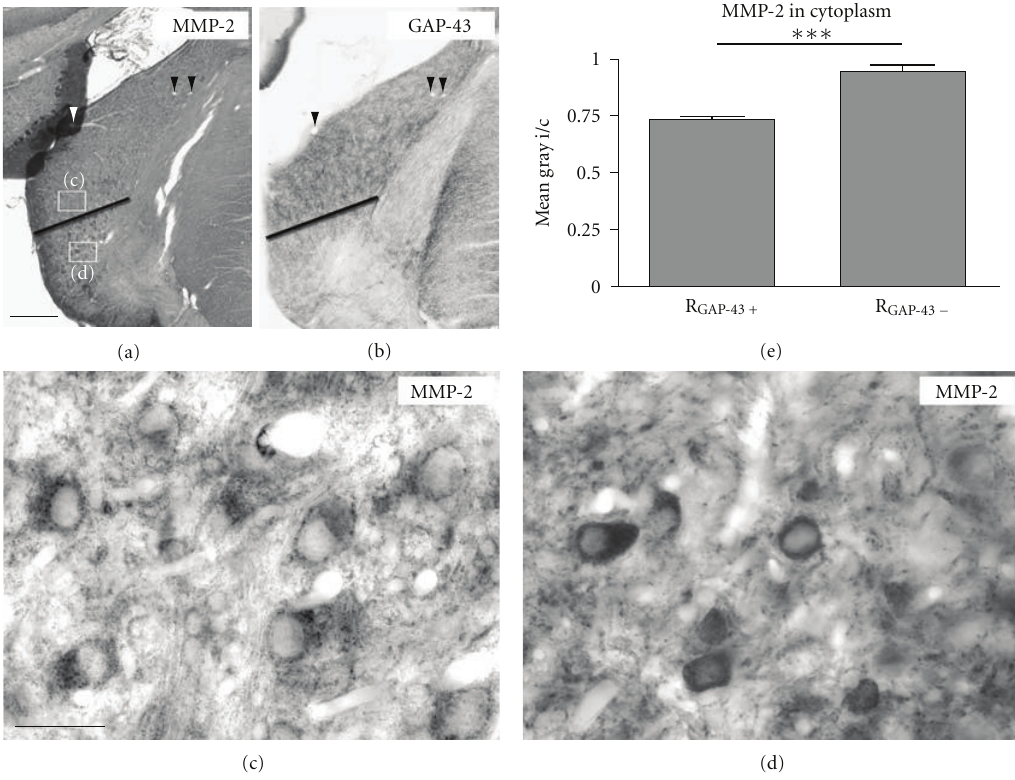
Figure 7: Distribution of MMP-2 in the ipsilateral AVCN on POD7 after incomplete lesion of VNTB due to KA injection followed by cochlear ablation. (a) Section through AVCN stained for MMP-2, showing a distinct border in the staining pattern of MMP-2 (black line). Frames indicate regions shown at higher magnification in (c) and (d). Arrowheads indicate blood vessels also found in the adjacent section shown in (b) stained for GAP-43. (b) In a section through AVCN parallel to the one shown in (a), GAP-43 expression shows a heterogeneity as well (black line) which closely corresponded to the border seen in (a). (c), (d) Photographs at high magnification taken of MMP-2 immunoreactivity in regions of AVCN corresponding to high expression level of GAP-43 (R GAP − 43+ ) and low to no expression of GAP- 43 ((R GAP − 43 − ), respectively. Scale bar: 200 μ m for (a), (b); 20 μ m for (c), (d). (e) Quantitative evaluation of MMP-2-staining intensity in cytoplasm of local populations of AVCN neurons based on photographs like those shown in (c) and